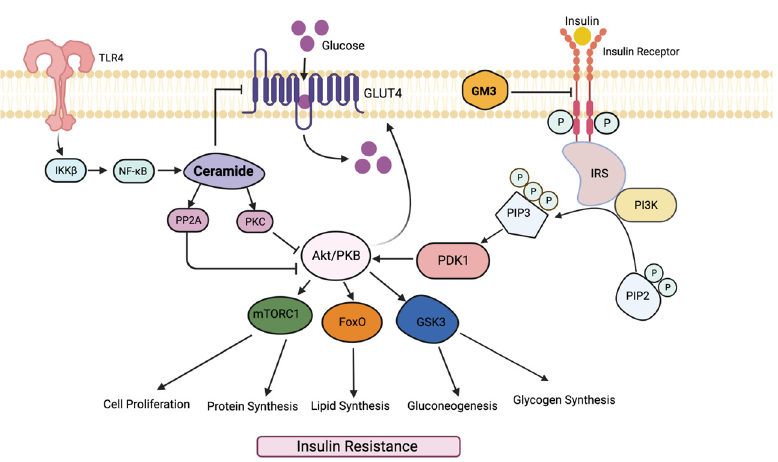
Figure 2. Insulin receptor-dependent and -independent pathways by which GM3 and ceramide, re- spectively, may be implicated in diabetes. IR binding to IRS triggers a signaling cascade that activates P13K. P13K signaling leads to downstream events such as GLUT4 translocation and activation of the Akt/PKB pathway. These pathways lead to cell proliferation, protein synthesis, lipid synthesis, gluconeogenesis, and activation of glycogen synthesis pathways. Ceramide and GM3 sphingolipids interrupt the insulin signaling pathway, creating a state of insulin resistance. Reprinted/adapted with permission from Ref. [38] 2022, Dr. Essam [38].